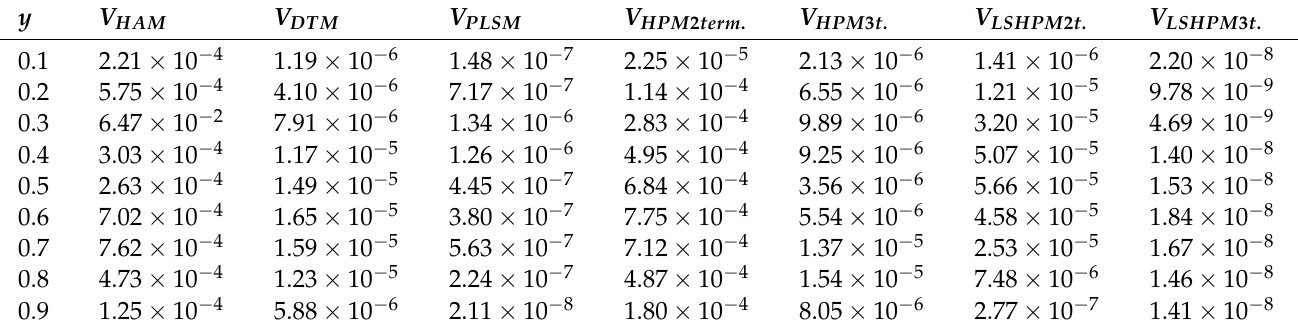
Table 2. Comparison of the absolute errors of the approximate solutions V in case Re = 1 and Ha =